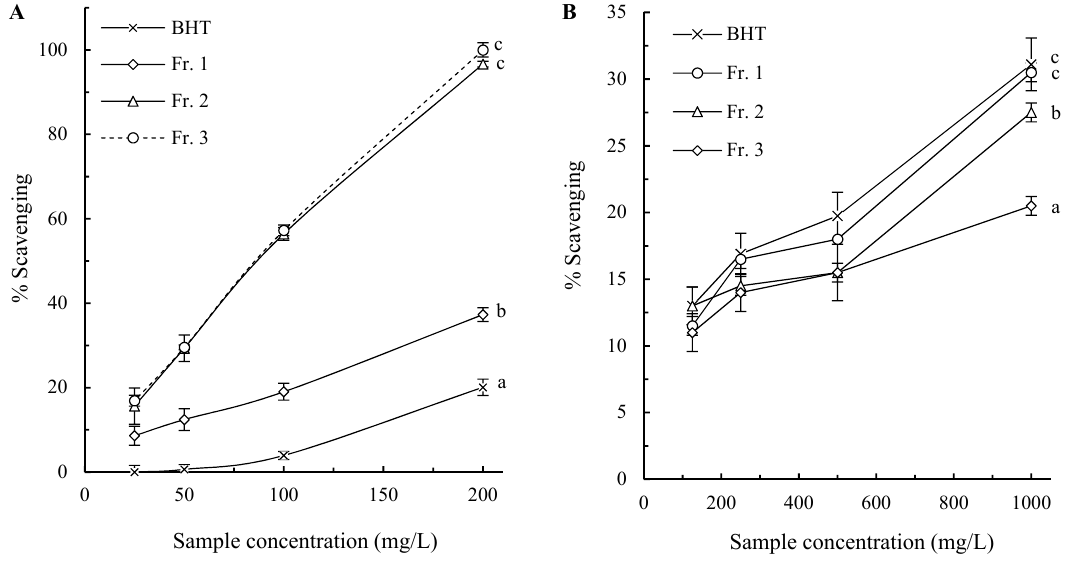
Figure 2. Dose dependent hydroxyl radical ( A ) and superoxide anion radical ( B ) scavenging effects of pigment fractions from chestnut shell. The lower case letters on the right of the curves indicate significant differences between means at sample concentration of 200 and 1000 mg/L for hydroxyl radical superoxide and anion radical scavenging, respectively ( p < 0.05).